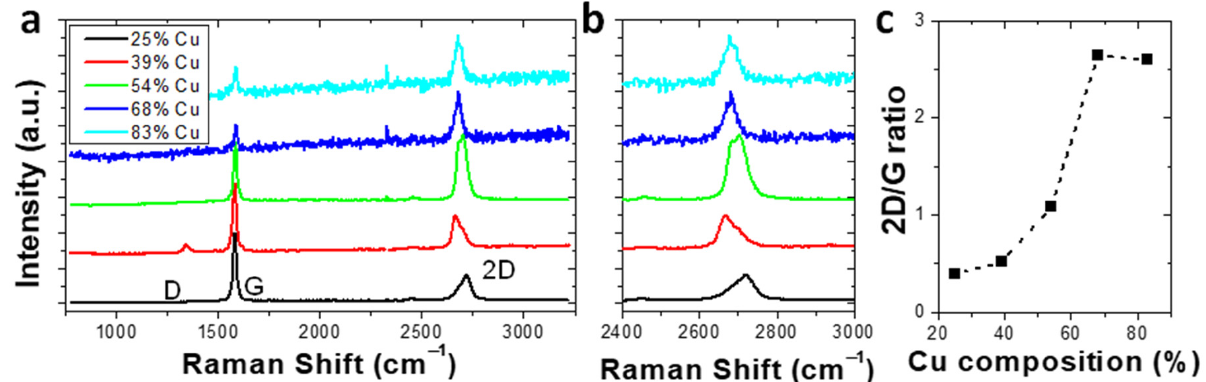
Figure 3. ( a ) Representative Raman spectra of graphene layers grown on Cu x Ni 1 − x catalyst at regions with varying Ni concentrations. ( b ) Raman spectra of the graphene 2D peak. ( c ) 2D/G ratio of Raman spectra as a function of catalyst Cu composition.